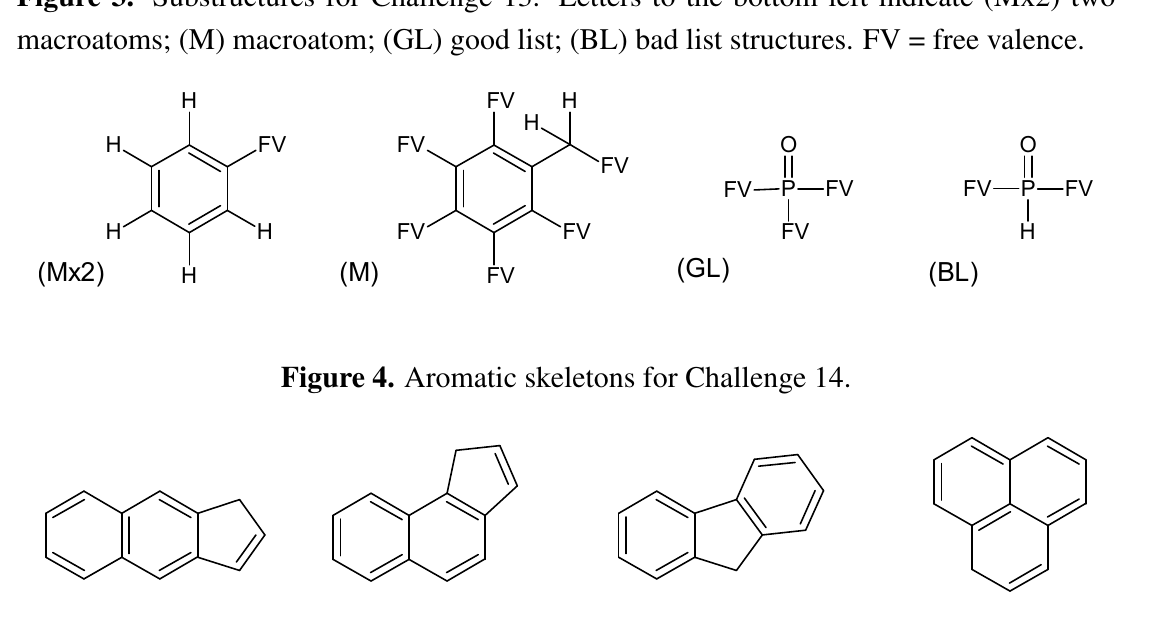
Figure 3. Substructures for Challenge 13. Letters to the bottom left indicate (Mx2) two